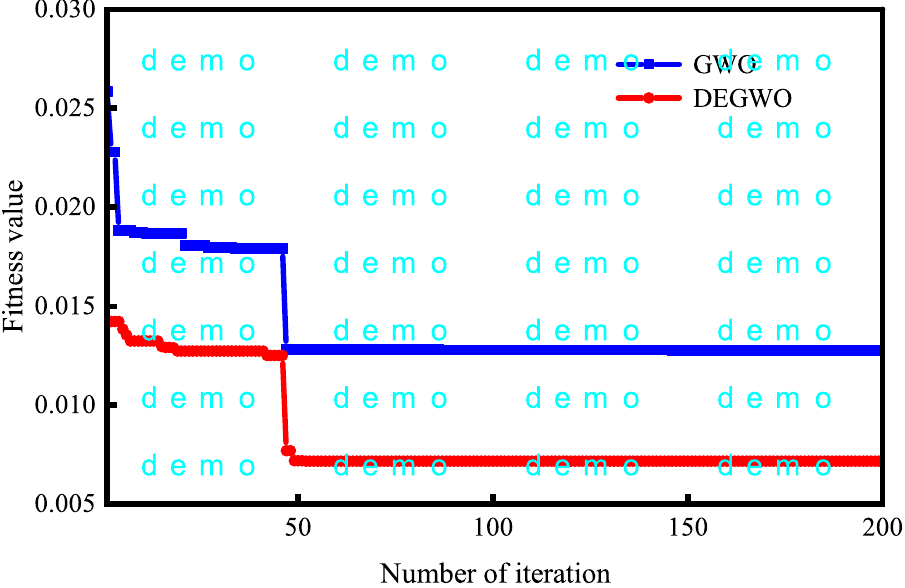
Fig 35. The fitness curves of the GWO and DEGWO model (conventional) of the PL13-2.